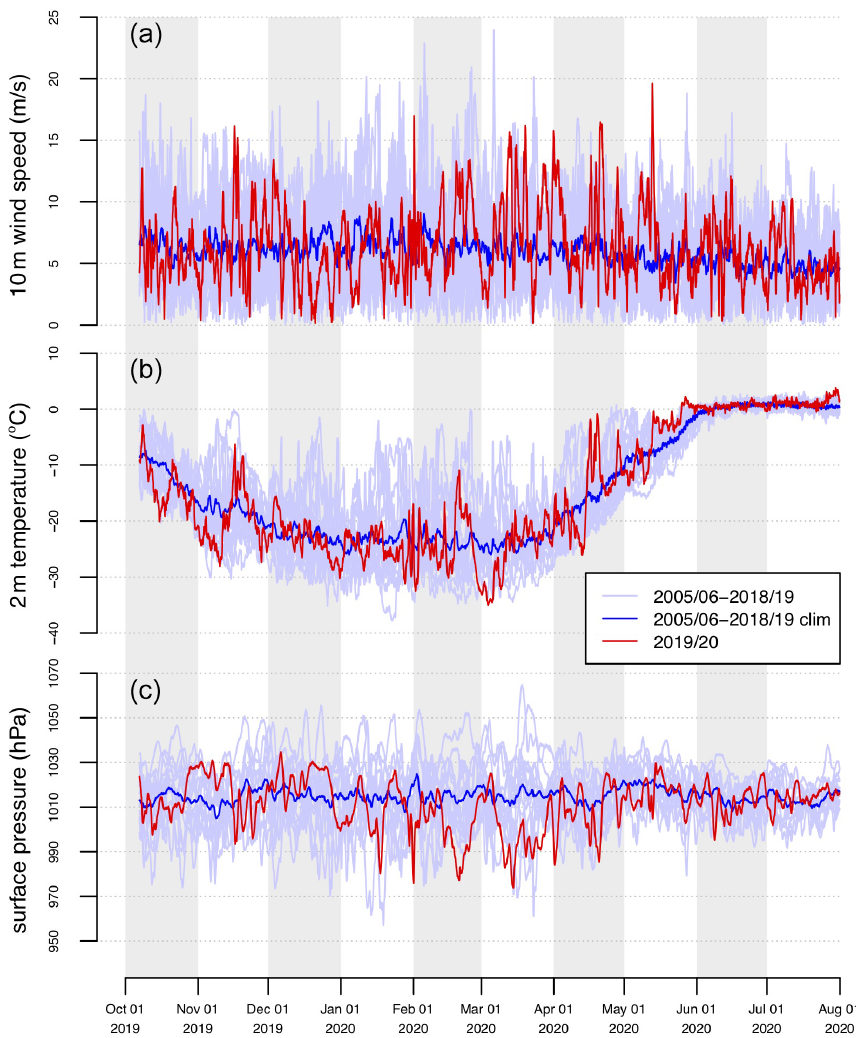
Figure 6. Hourly atmospheric conditions along the MOSAiC drift trajectory according to ERA5 in 2019–2020 (red) and in the preceding 14 years (light blue; average in dark blue). Panels show the (a) 10m wind speed, (b) 2m air temperature and (c) surface air pressure, respectively. See Fig. 7 for a comparison with corresponding ship